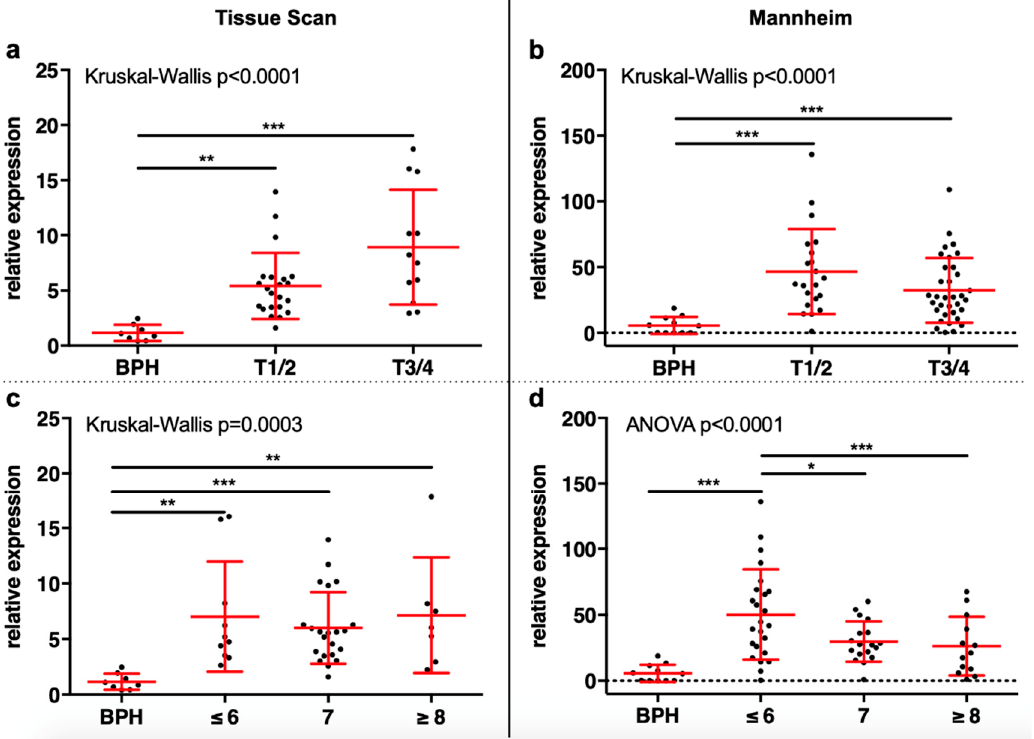
Figure 1. Expression of Sphingomyelin Phosphodiesterase Acid Like 3B (SMPDL3B) was analyzed by qRT-PCR. ( a ) Both locally confined and locally advanced tumors showed an overexpression of SMPDL3B compared to benign prostate hyperplasia (BPH). ( b ) In the Mannheim cohort, T1/2 and T3/4 tumors had an SMPDL3B overexpression. ( c ) All three Gleason groups had an SMPDL3B overexpression in the tissue scan cohort. ( d ) In the Mannheim cohort, Gleason 6 tumors had an overexpression of SMPDL3B both compared to BPH and to Gleason 7 and ≥ 8 tumors. (* p > 0.05; ** p > 0.01; *** p > 0.001)